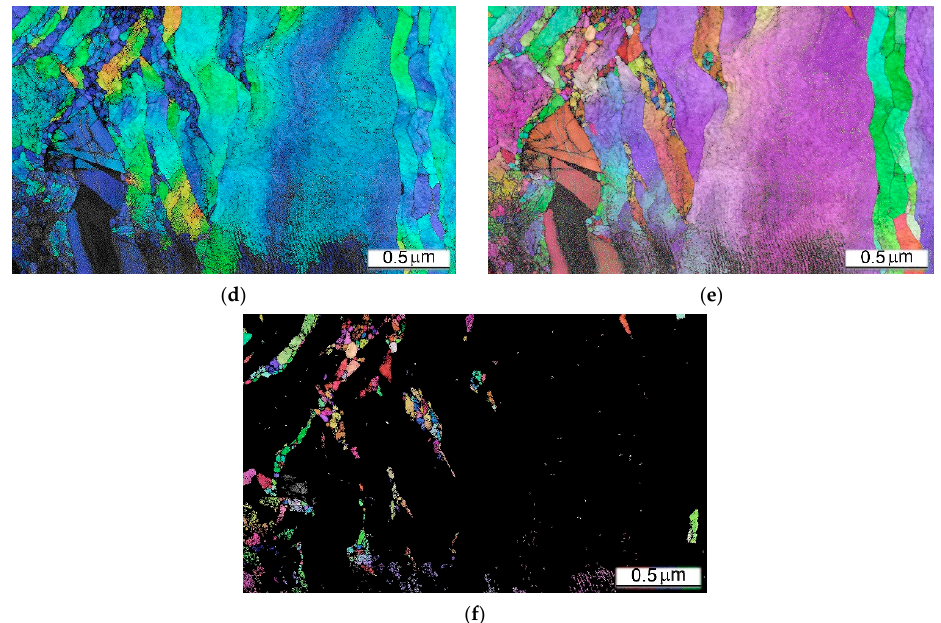
Figure 21. TKD results of the heavily deformed region (ASB area) on the sample Ti64BEPM + 10TiB after SHPB test with the strain rate 2510 s − 1 . EBSD (conventional) phase map ( a ) showing the area from where the lift-off sample (AB section) for TKD was taken; within α -phase is shown in green, β -phase in blue and TiB is in magenta colors. The rest of the images ( b – f ) show TKD results: phase map ( b ), similarly color coded as in ( a ); grains map, in random color ( c ); GAM map ( d ); IPFz ( e ); IPFz map showing the grains <100 nm ( f ).